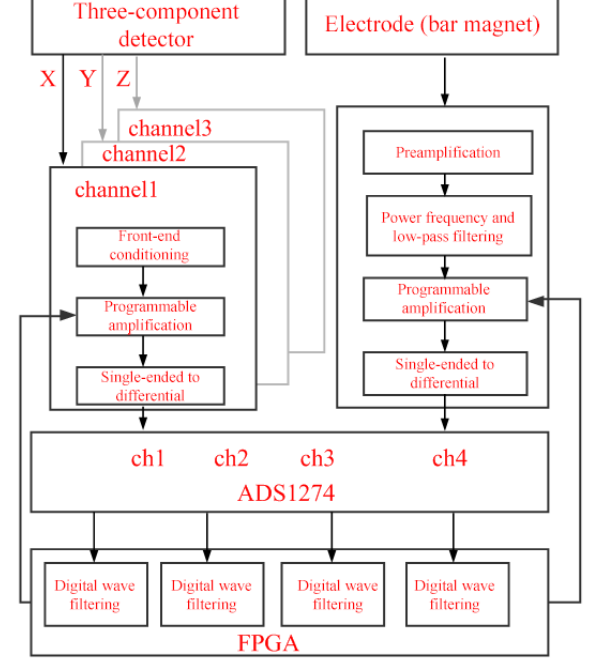
Figure 1. Structural block diagram of the hybrid acquisition system based on the ADS1274 high-precision seismic electrical